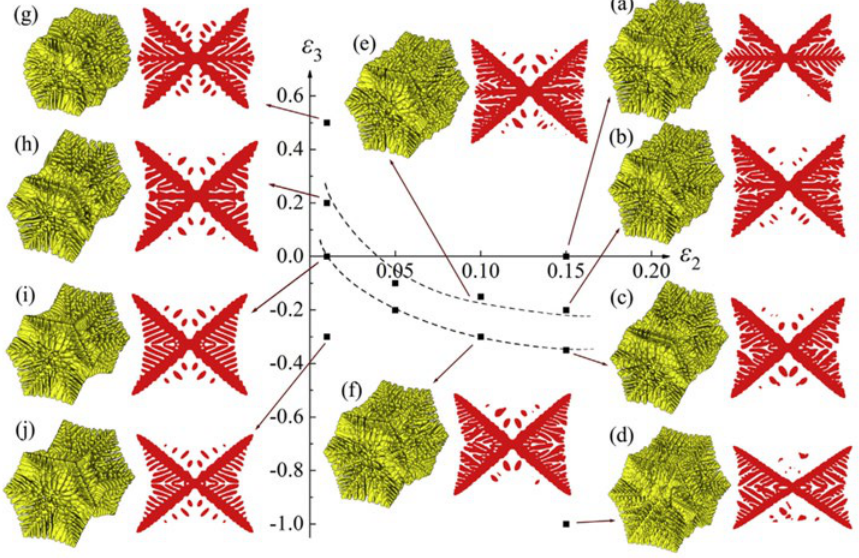
Figure 7. Effects of different Zn contents on dendrite morphology. ( a – j ): 3D and 2D dendrite morphology under different anisotropy parameters ε 2 and ε 3 combinations